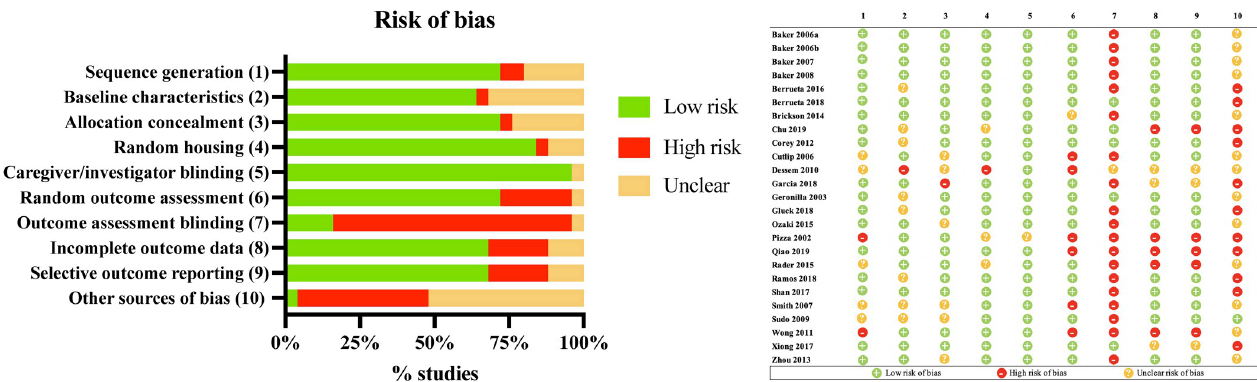
Fig 2. Methodological quality of studies using SYRCLE’s risk of bias assessment tool. (A) The risk of sequence generation, baseline characteristics, and other biases was assessed for the studies included in this review. Eight categories have a low risk of bias in more than 50% of the studies, except of outcome assessment blinding and other sources of bias. (B) Studies fulfilling the criteria of: (1) Sequence generation; (2) Baseline characteristics; (3) Allocation concealment; (4) Random housing; (5) Caregiver/investigator blinding; (6) Random outcome assessment; (7) Outcome assessment blinding; (8) Incomplete outcome data; (9) Selective outcome reporting; (10) Other sources of